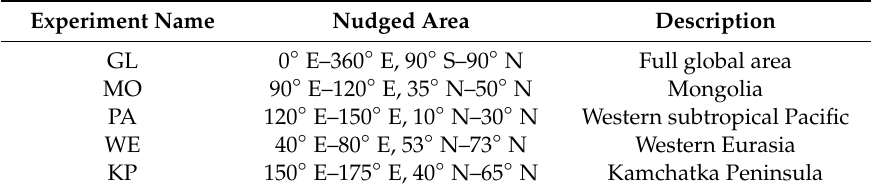
Table 1. Description of nudging